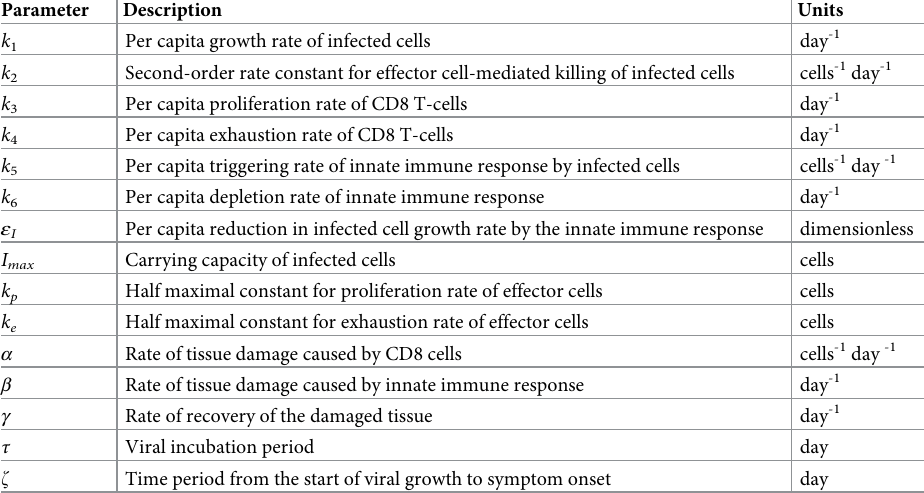
Table 1. Model parameters and their